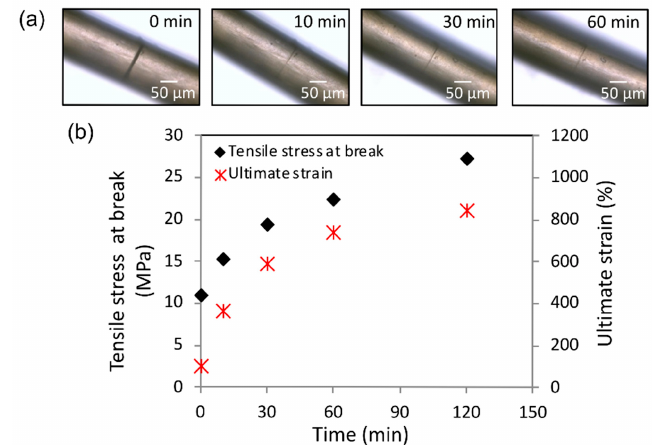
Figure 7. Self-healing of microphase-separated cold-drawing programmed polyurethane (PURP) fibers. ( a ) Optical images of PURP fiber. ( b ) Tensile stress at break and ultimate strain plotted as a function of healing time. Undamaged samples have an ultimate strain of 1015% and a tensile stress at break of 29.2 MPa. Values are the average of N = 6. Reprinted from [45], Copyright 2018, with permission from Elsevier